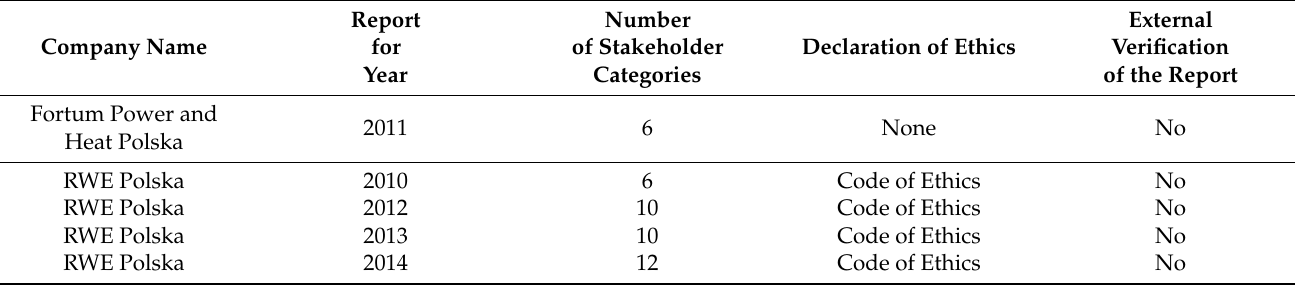
Table 3. The results of overview of the energy companies’ reports in terms of stakeholder relations, ethical compliance and external